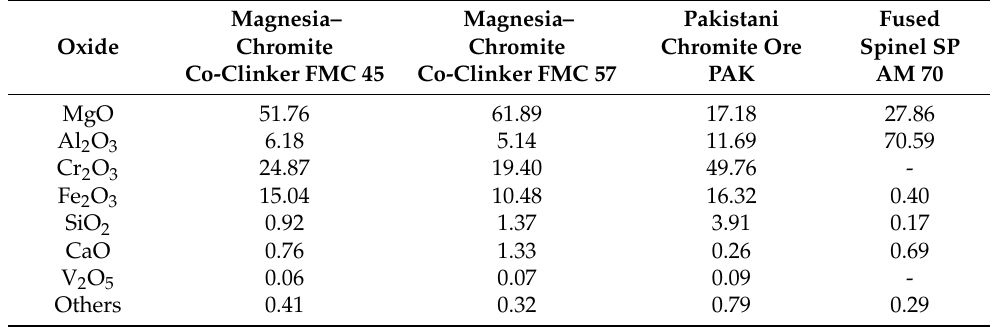
Table 2. Chemical composition (wt.%) of refractory raw materials by